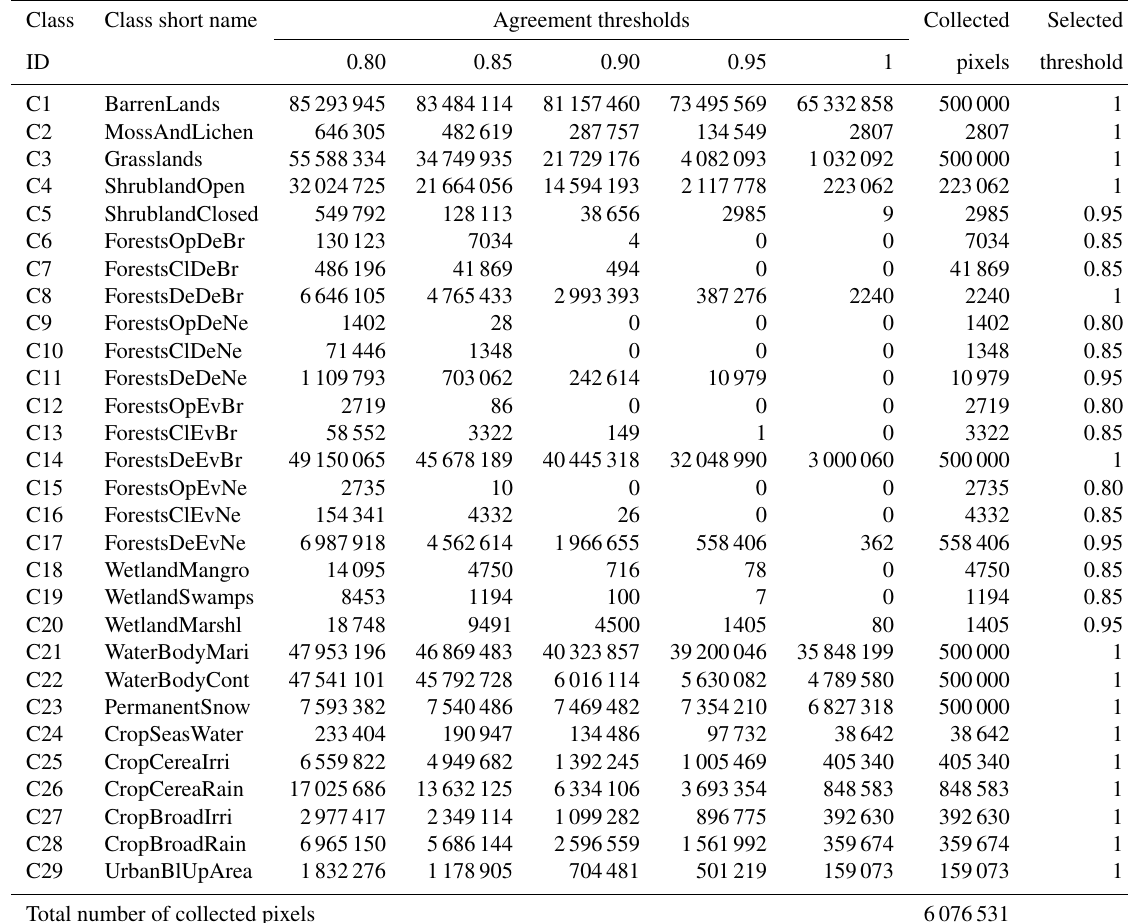
Table 7. Sensitivity analysis of the number of pixels with respect to different values of agreement thresholds along with the final number of collected pixels at the selected threshold. When the number of pixels at threshold 1 exceeds 1 million, we collect 500000 random pixels. Otherwise, we decrease the threshold by 0.05 until we obtain at least 1000 pixels (Algorithm